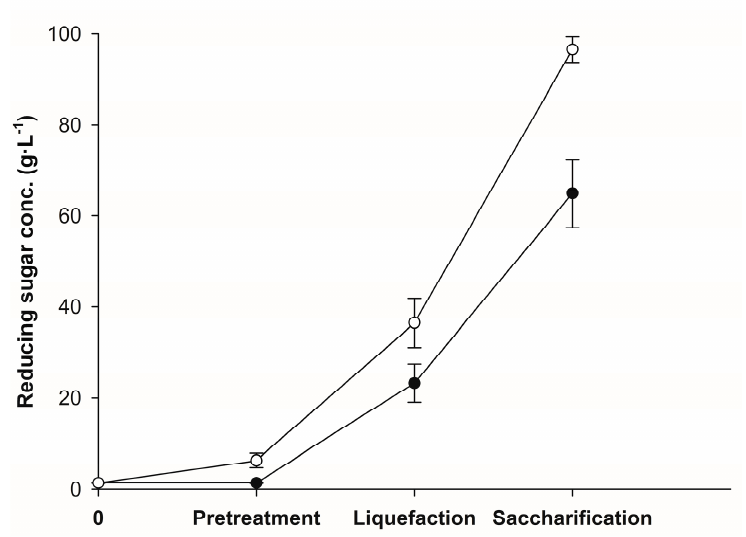
Figure 3. Production dynamics of reducing sugars in the Ramon flour enzymatic hydrolysis. Open symbols thermic pretreatment 90 °C for 30 min. and solid symbols without pretreatment. The results are represented as the mean ± standard deviation of three parallel measurements ( n = 3).